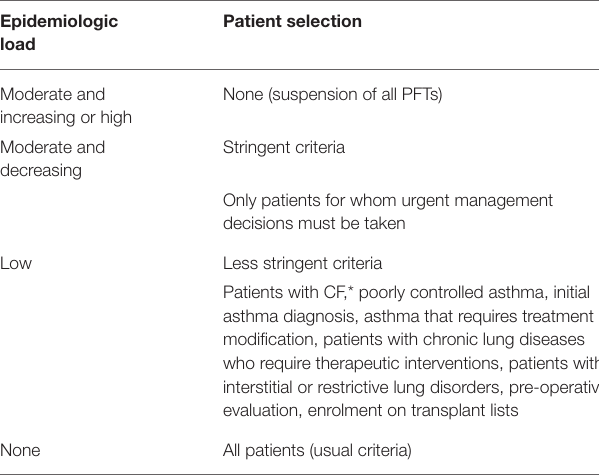
TABLE 3 | Patient selection criteria for performing PFTs during the COVID-19 pandemic. Epidemiologic